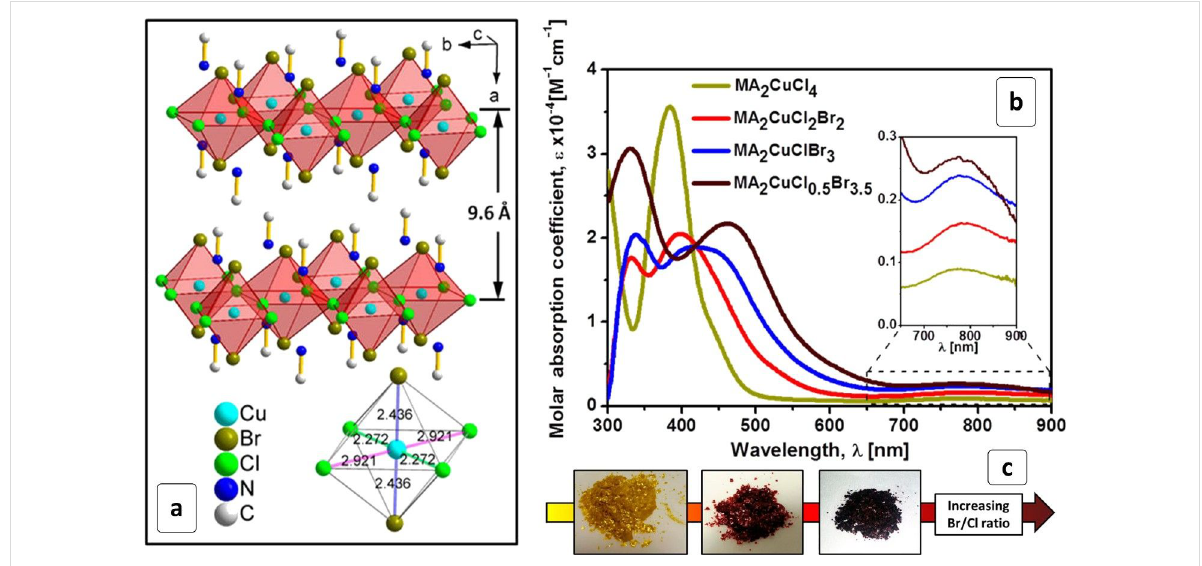
Figure 10: Structure (a), absorption spectra (b) and photographs (c) of (CH 3 NH 3 ) 2 CuCl x Br 4 − x HPs of different composition. Reprinted and adapted with permission from [152], copyright 2016 American Chemical Society.